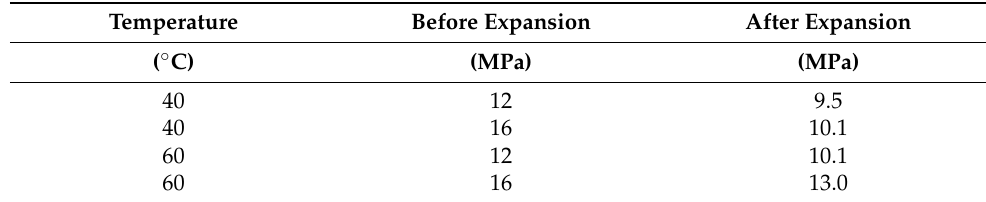
Table 1. Theoretical pressures after expanding scCO 2 at 12 and 16 MPa from 100 to 125 mL.